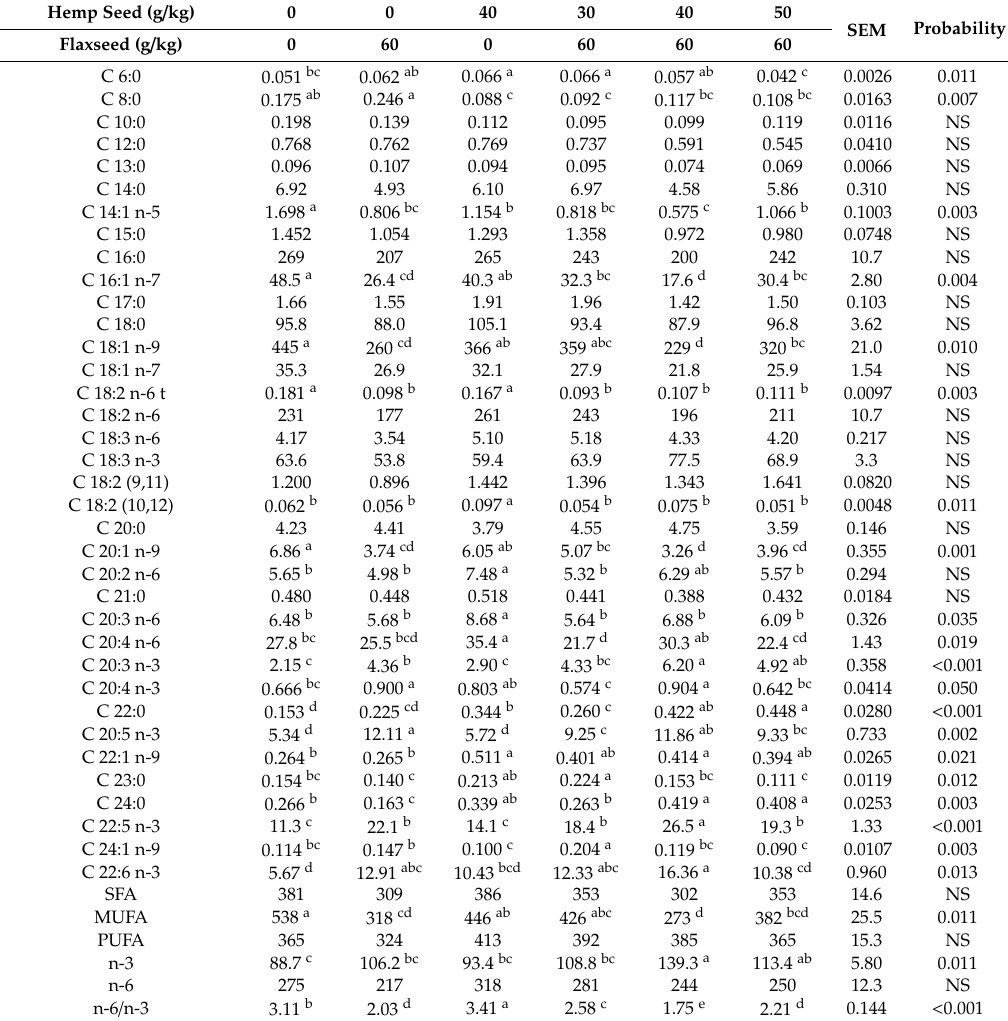
Table 6. Concentration of fatty acids in the breast meat of broilers (mg / 100